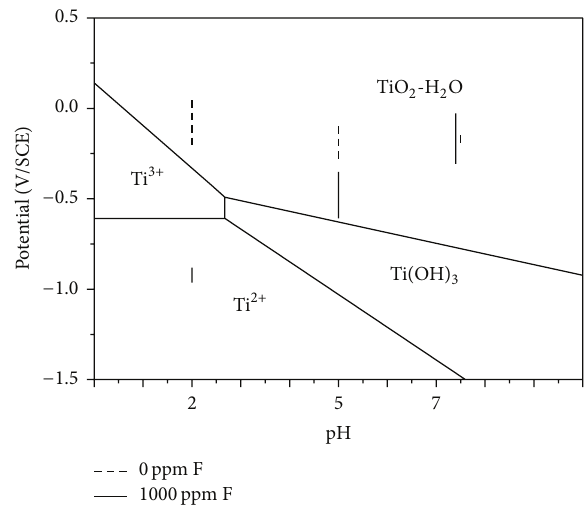
Figure 2: Ranges of OCP values measured after 3 h exposure in Ringer’s solution of pH 2, 5, and 7.5 without fluoride and containing 1000ppm F at 37 ∘ C.